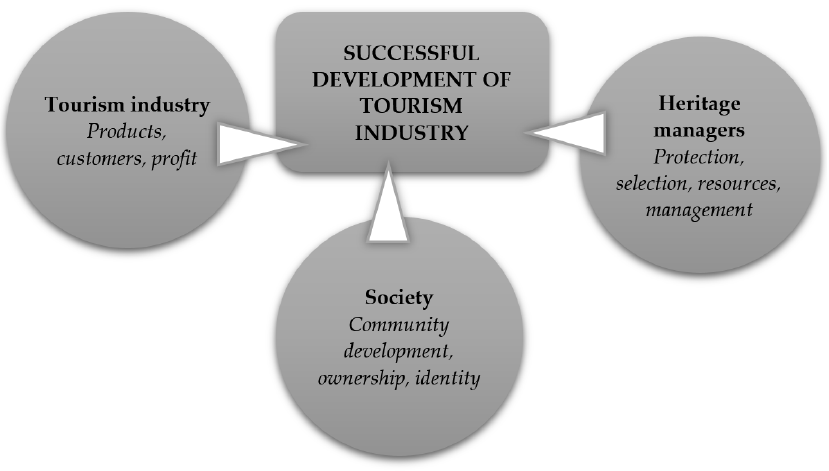
Figure 19. AHC Model of Heritage management. Source: Jurėnienė and Radzevičius (2014), Models of Cultural Heritage, Transformations in Business and Economics, Vol. 13, No 2 (32), p. 244.